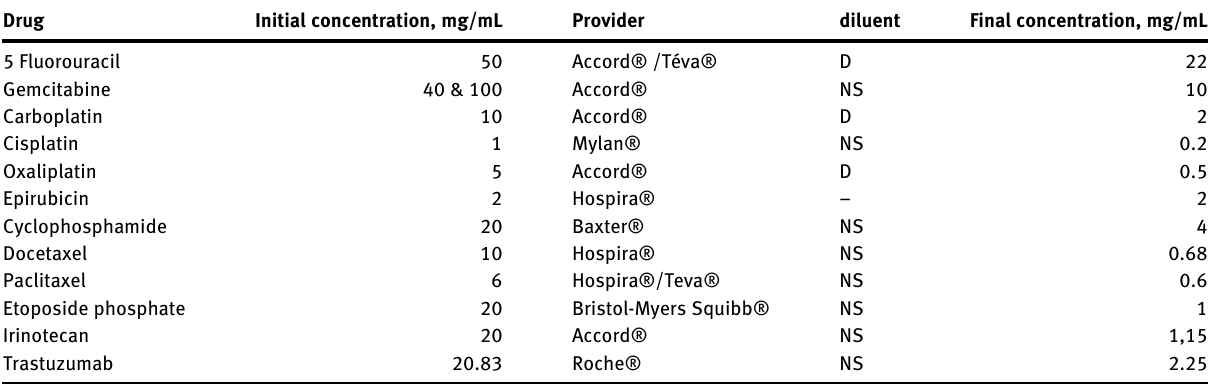
Table  : Anticancer drug solutions investigated for batch